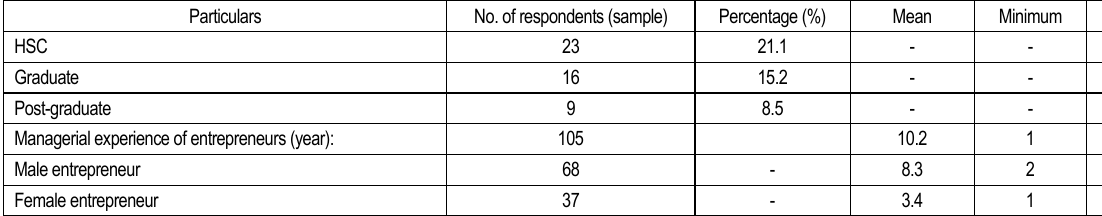
Table 2 (cont.). Information about entrepreneurs (respondents)